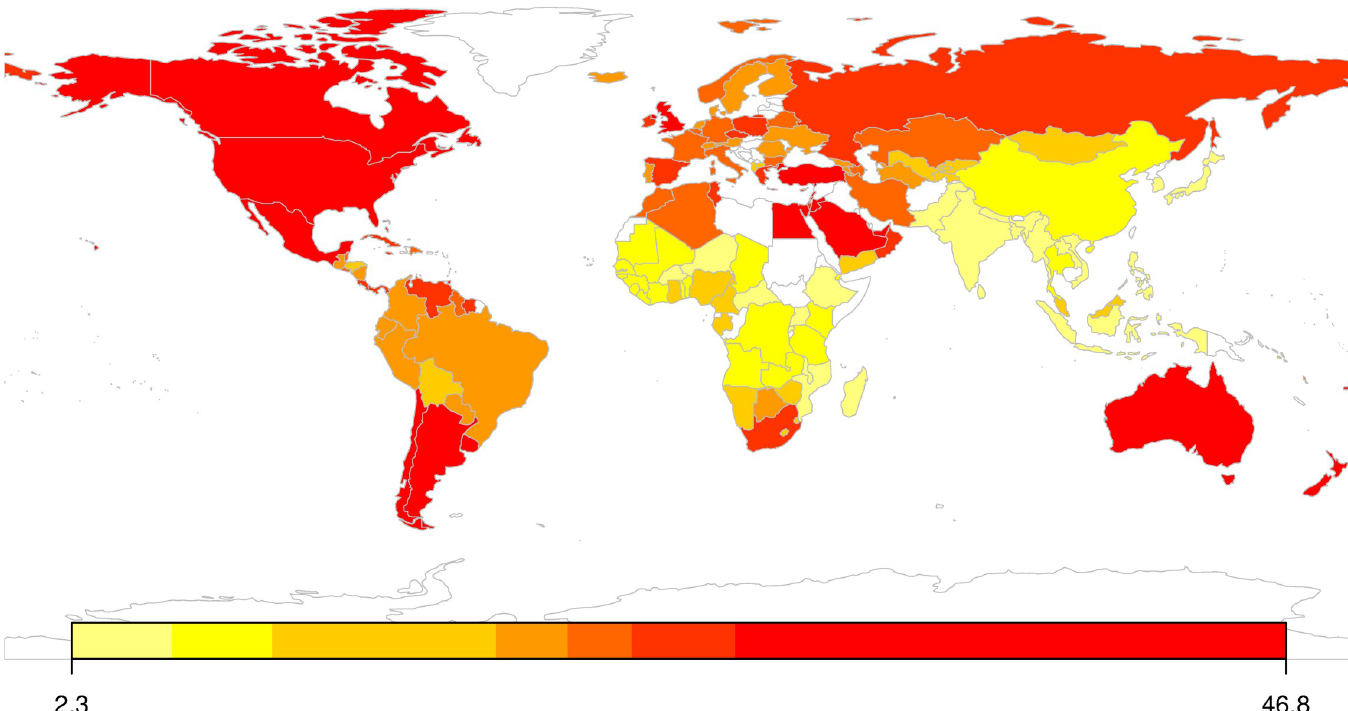
Fig 1. Prevalence of adult obesity in 147 countries worldwide. Proportion of obese adults in countries are represented by color scales. The map was created using Rworldmap package in R [38].